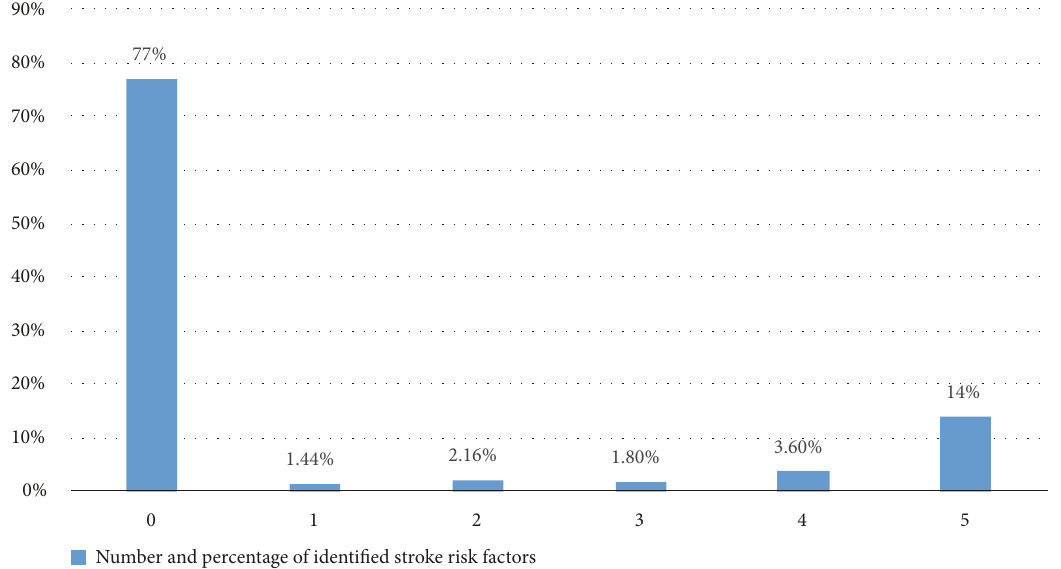
Figure 1: Number and percentage of identified stroke risk factors. Table 2: Socio-demographic characteristics associated with general knowledge of hypertensive